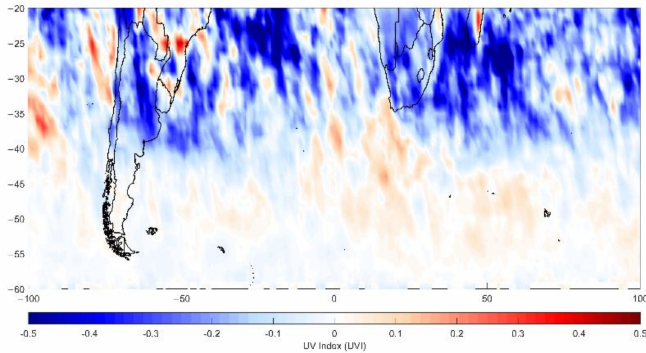
Figure 2. Ultraviolet index (UVI) anomalies for June 2011 where positive values indicate an increase in UVI and vice